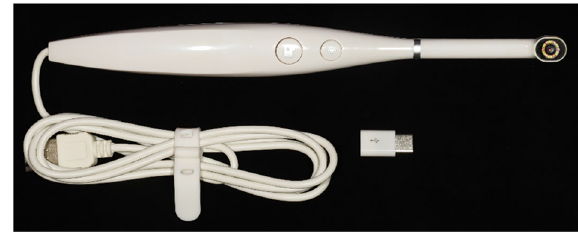
Fig. 2 The intraoral camera used in teledentistry.